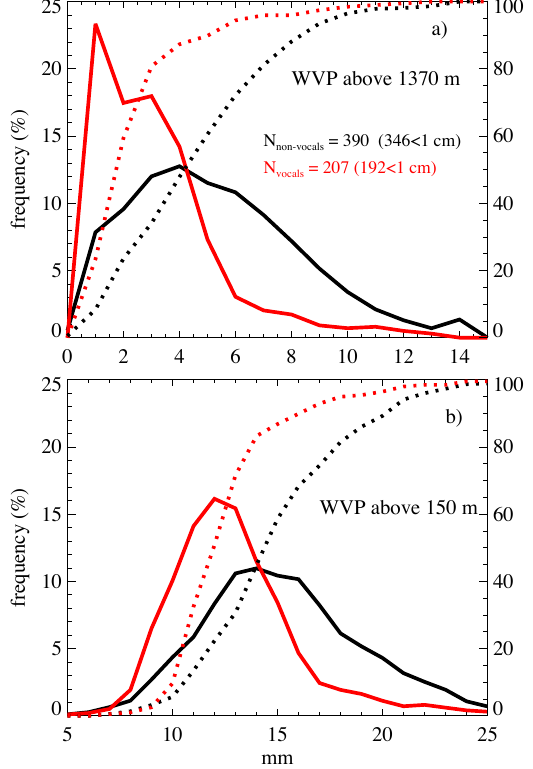
Fig. 1. (a) Histogram of free-tropospheric water vapor path val- ues calculated from ship-board radiosondes prior to VOCALS-REx, and VOCALS-REx separately (black and red lines, respectively). Dotted lines indicate the cumulative frequency of occurrence. (b) Same as (a) but for the water vapor paths overlying the sub-cloud aircraft legs at 150m altitude. All radiosondes were released be- tween 0 ◦ and 23 ◦ S and east of 97 ◦ W and all reached at least